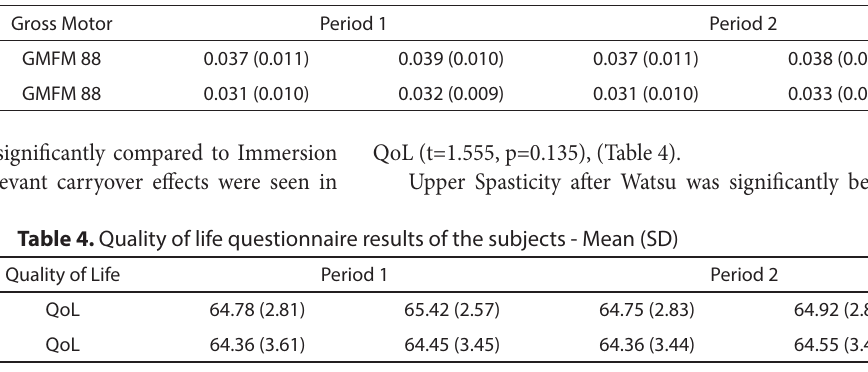
Table 3. GMFM 88 measurement results of the subjects - Mean (SD)